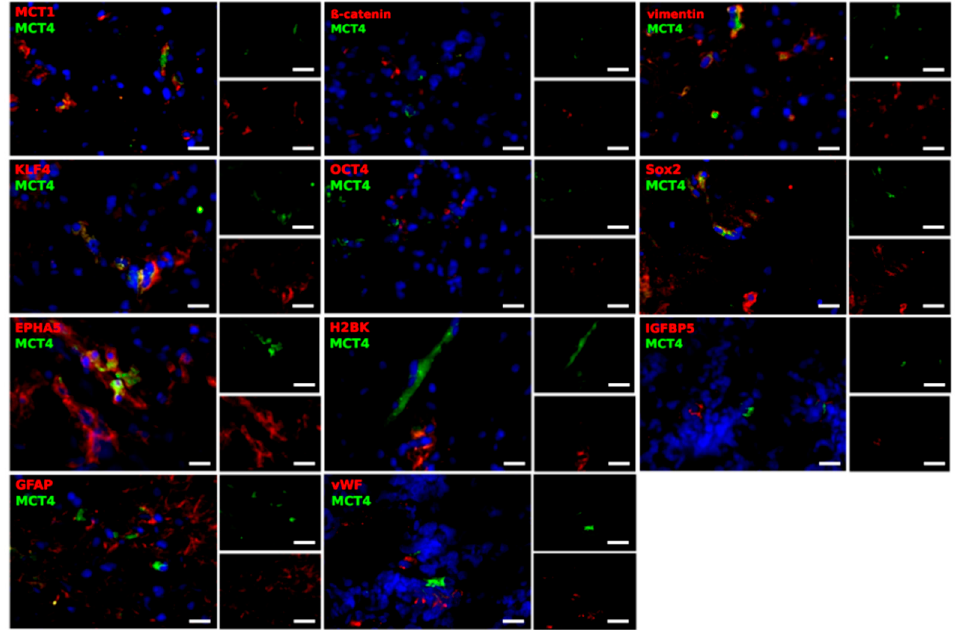
Figure 6. Representative co-staining of MCT4 with EMT markers ( β -catenin, vimentin), stem-like cell markers (KLF4, OCT4, Sox2), dormancy markers (EPHA5, H2BK, IGFBP5) and GFAP, as well as vWF, in pairs of center and edge glioblastoma samples, as determined by immunofluorescence microscopy. MCT1 and MCT4 (green) are found in di ff erent combinations with cell-specific markers (red) in a complex pattern. Magnification 400×; bar = 20 μ m.